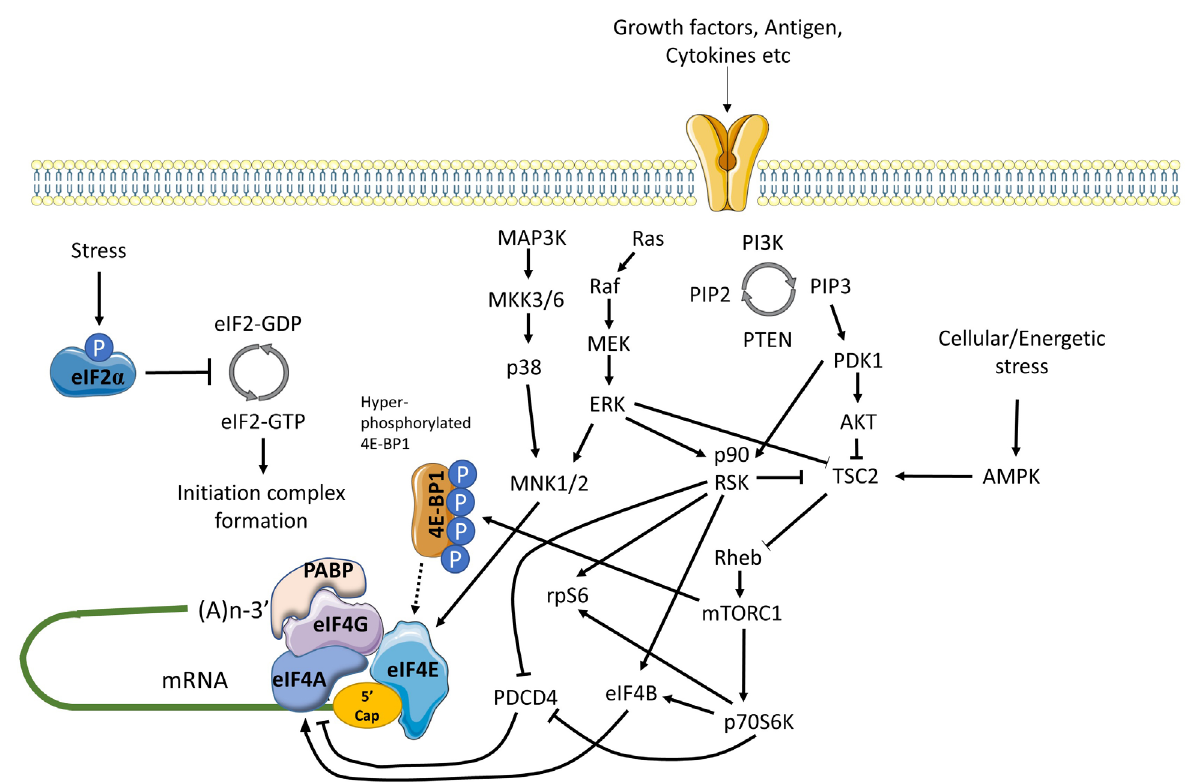
Figure 3. Positive and negative regulation of mRNA translation initiation by signaling pathways. mRNA translation is promoted by PI3K/AKT/mTORC1 and MAPK signaling. mTORC1 is activated via repression of TSC2-mediated conversion of Rheb-GTP to inactive Rheb-GDP. mTORC1 promotes the hyper-phosphorylation of 4E-BP1 which prevents inhibitory association with eIF4E, facilitating eIF4F complex formation. mTORC1 additionally activates p70S6K which indirectly activates eIF4A via repression of PDCD4 and activation of eIF4B. MAPK signaling leads to activation of MNK1/2 (and downstream phosphorylation of eIF4E) via MEK/ERK and p38 pathways, and ERK which with downstream-activated p90RSK, also relieves TSC2 mediated repression of mTORC1. In response to energetic stress AMPK is activated which promotes TSC2 mediated conversion of Rheb-GTP to Rheb- GDP to inhibit mTORC1. Other stress stimuli promote eIF2α phosphorylation that arrests the eIF2 complex in its inactive GDP- bound form repressing mRNA